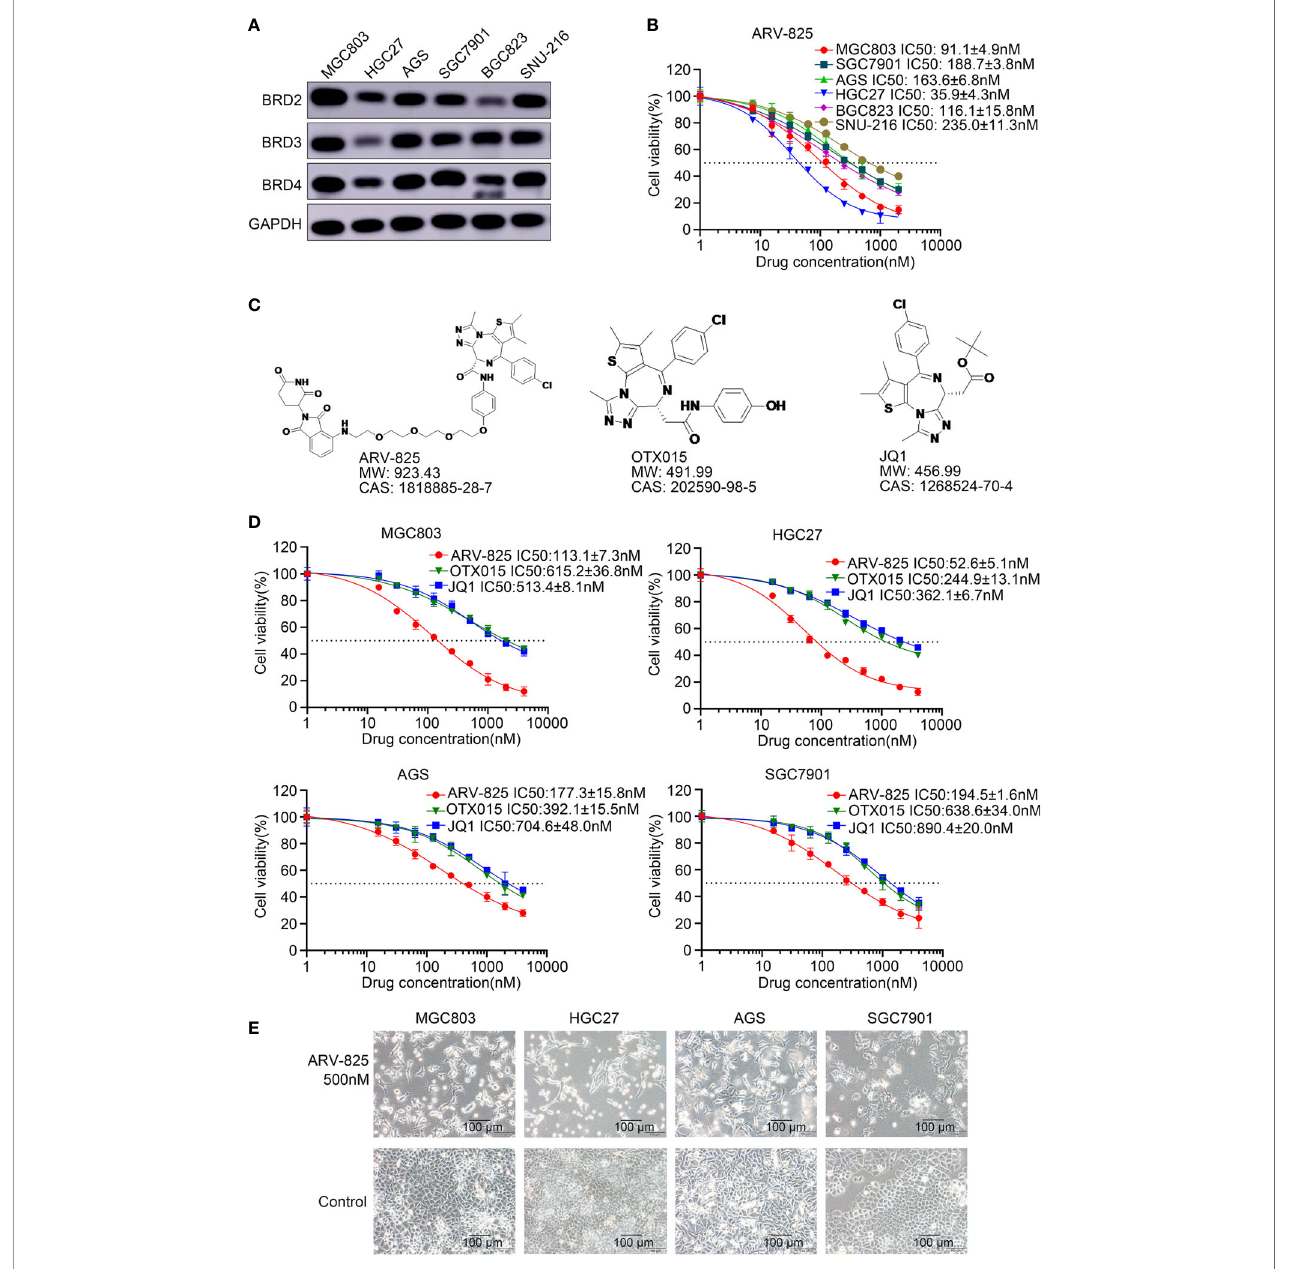
FIGURE 2 | ARV-825 suppresses the viability of gastric cancer cells. (A) BET protein levels in gastric cancer cells. (B) Viability of gastric cancer cells treated with ARV-825 at different concentrations. Values of IC50 have been calculated and shown on the graph. (C) Chemical structures of ARV-825, OTX015, and JQ1. (D) The cell viability of MGC803, HGC27, AGS, and SGC7901 cells treated with ARV-825, OTX015, and JQ1. (E) Morphology of MGC803, HGC27, AGS, and SGC7901 cells treated with